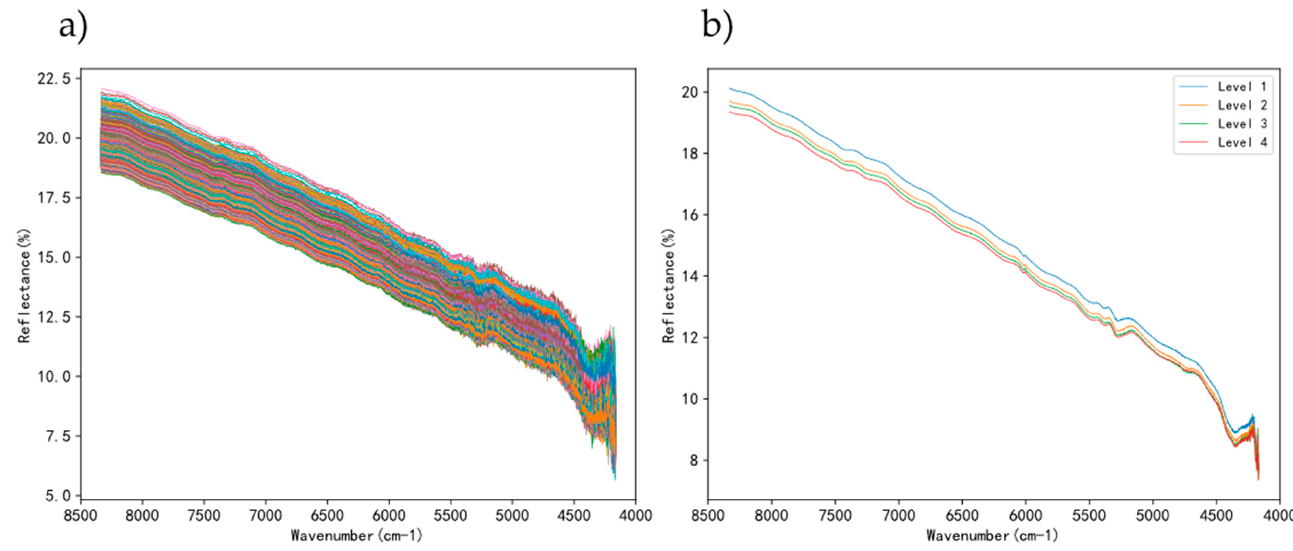
Figure 3. Near-infrared (NIR) spectra of steel coating: ( a ) raw data for all samples; ( b ) mean spectra of different grades of the coating condition.